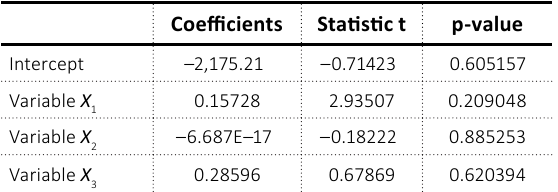
Table 8. Correlation